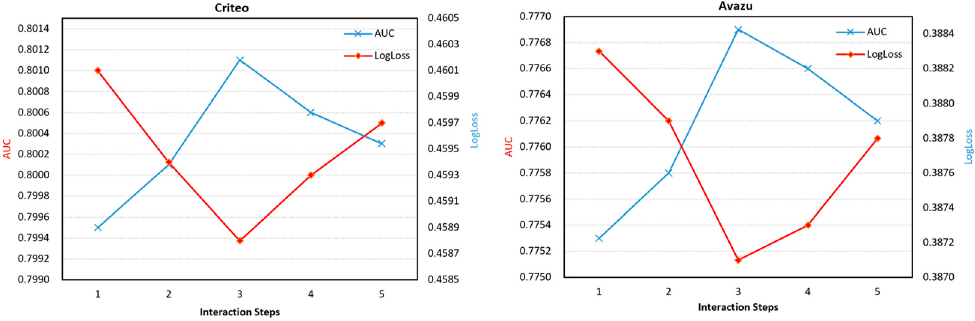
Figure 6. Performance of GAIAN model under different feature interaction